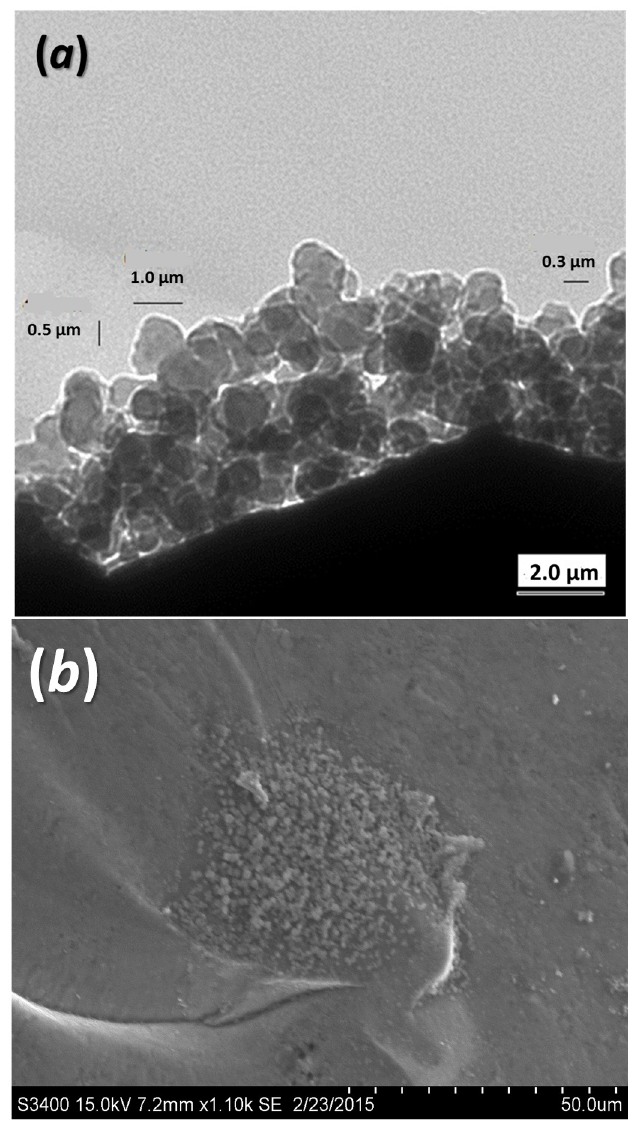
Figure 2. ( a ) TEM image shows the grain size of ball milled SiGe powder before